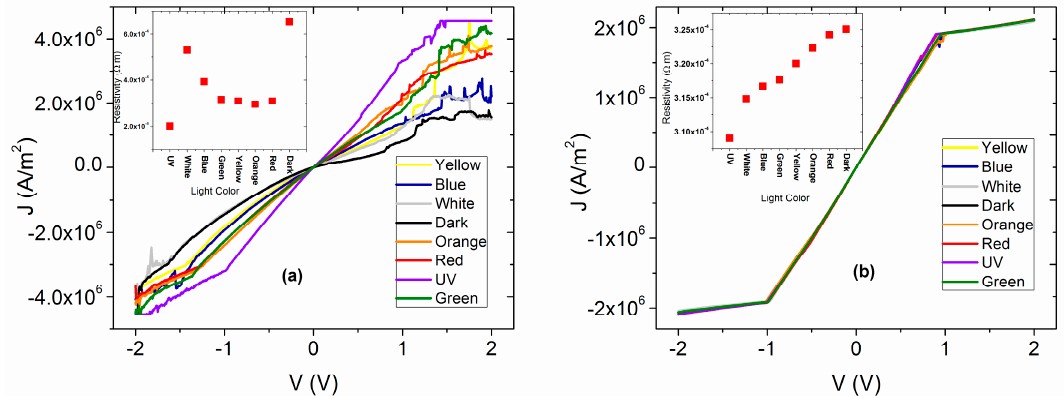
Figure 4. J-V characteristics of ( a ) annealed membrane and ( b ) semiconductor film where ITO is positively biased.